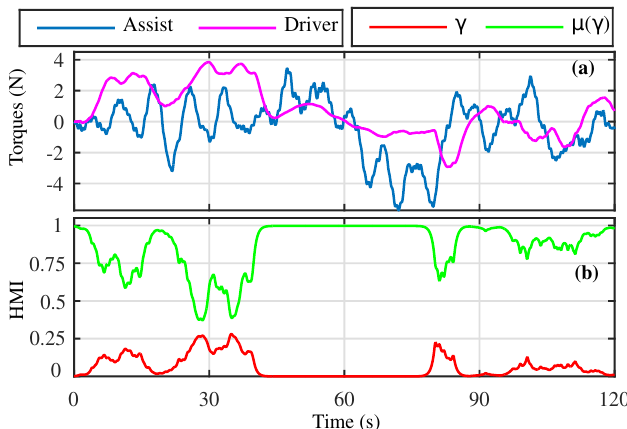
Figure 6. The HMI under the CLKA-HOSM controller. ( a ) Driver and Assistance Torque; ( b ) Driver activity and the level of assistance